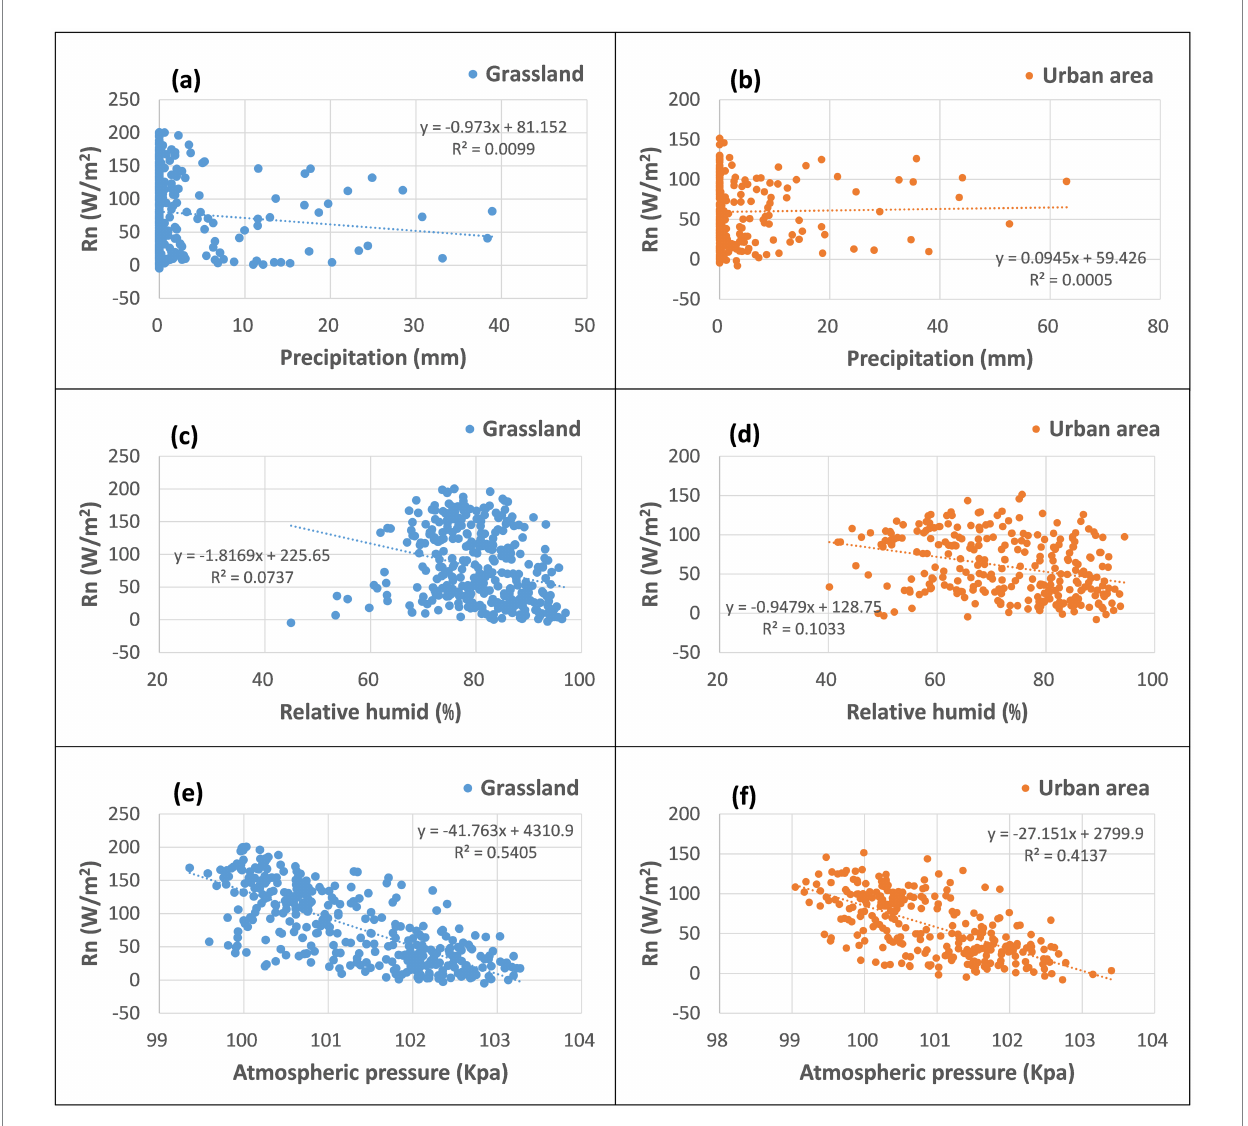
FIGURE 5 Correlations between Rn and the atmospheric variables of precipitation (A,B) , relative humidity (C,D) , and atmospheric pressure (E,F) in grassland and urban